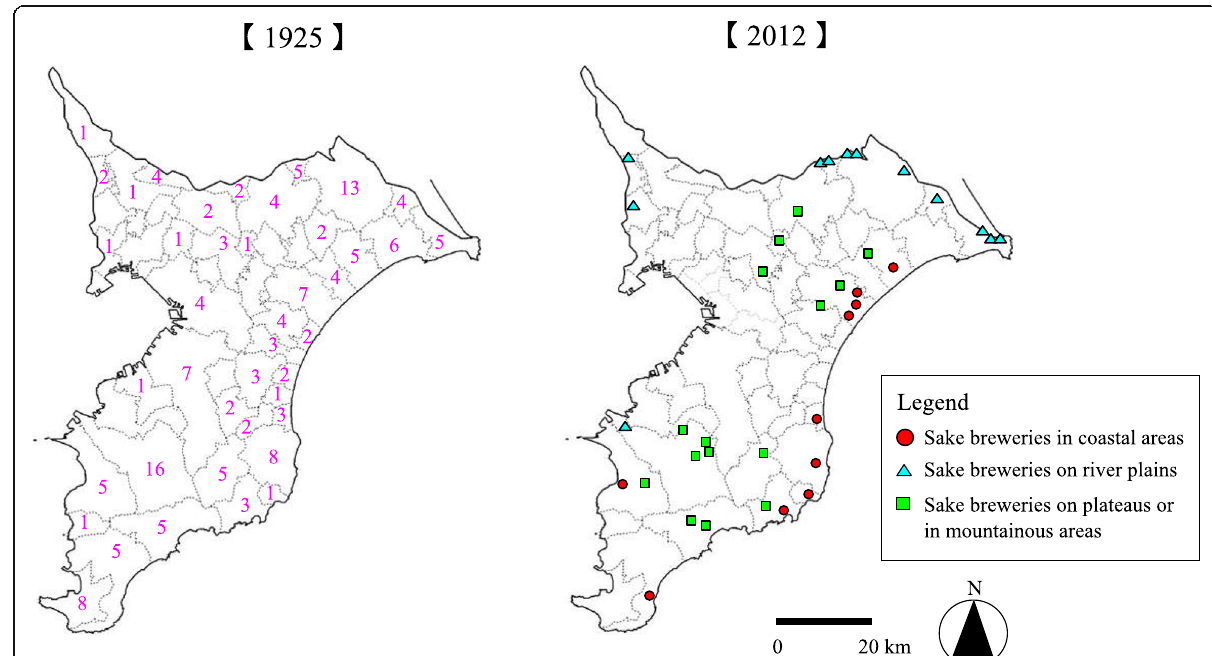
Fig. 3 Numbers of sake breweries in 1925 and locations of sake breweries in 2012. Light gray lines indicate municipal boundaries in 2017. The base map was created by the Geospatial Information Authority of Japan